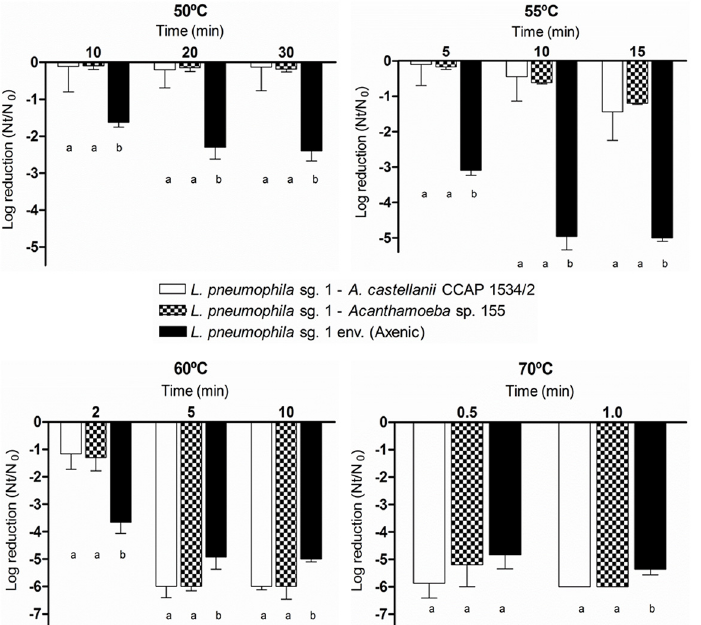
Fig 7. Effect of thermal treatments on the inactivation of L . pneumophila sg. 1 env. associated to two Acanthamoeba strains, A . castellanii CCAP 1534/2 and Acanthamoeba sp. 155 strains. Bacterial inactivation was determined using viable counts on BCYE medium. Data are presented as means ± SD (columns and error bars; n = 3). Statistical differences between means within each time point were represented assigning different letters to the bar plot. The same letter was assigned to bars with no significant differences between them. Statistical analyses were performed by ANOVA and pairwise Fisher ’ s LSD test ( p <